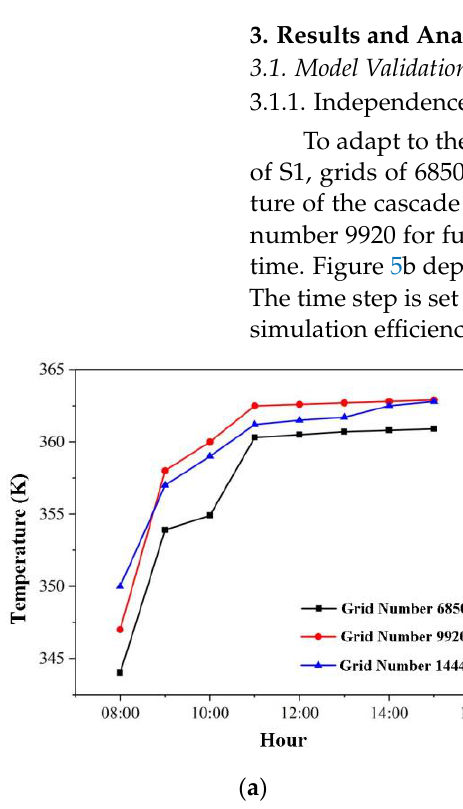
Figure 5. Independence analysis of grid number and time step: ( a ) with different grid numbers; ( b ) with different time steps.